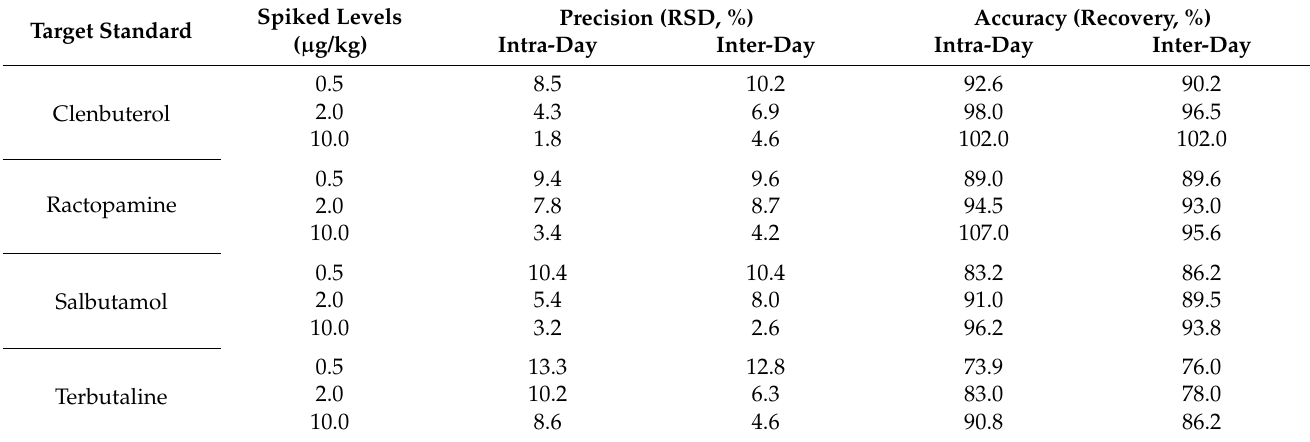
Table 4. Accuracy and precision for the determination of β 2 -agonists in ham using an SCR SPE cartridge (n =